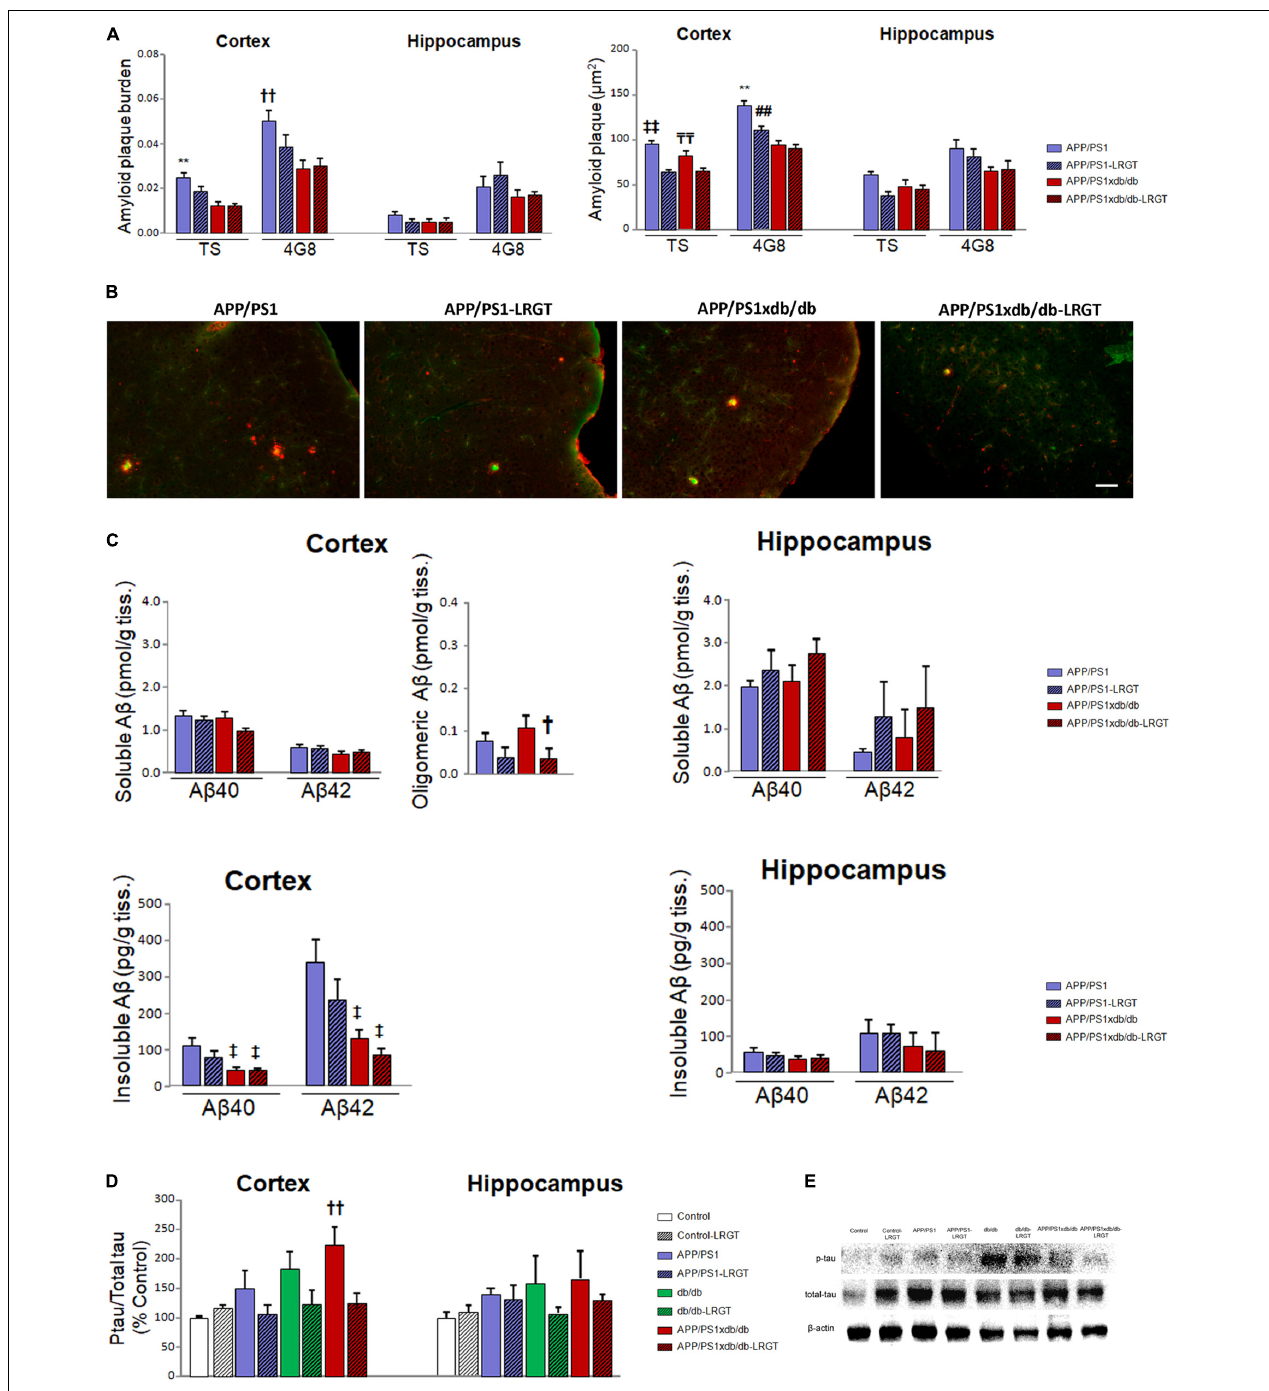
FIGURE 4 | LRGT affects amyloid and tau pathologies in APP/PS1xdb/db mice. (A,B) Amyloid plaque burden and size are quantified by thioflavin S and 4G8 staining. (C) A β 40, A β 42, and A β aggregates are also determined in APP/PS1 and APP/PS1xdb/db mice after liraglutide treatment (500 µ g/kg/day) for 22 weeks. (D,E) Phospho-tau/total tau ratios are also measured in all the genotypes (Control, APP/PS1, db/db, and APP/PS1xdb/db) under study untreated or after LRGT treatment (complete statistical analysis included as a Supplementary Material ). (A) LRGT treatment reduced amyloid plaque burden in the cortex from APP/PS1 mice (** p < 0.01 vs. rest of the groups; †† p < 0.001 vs. APP/PS1xdb/db, and APP/PS1xdb/db-LRGT). No differences were observed in the hippocampus. LRGT treatment also reduced amyloid plaque size in the cortex from APP/PS1xdb/db mice ( p < 0.01 vs. APP/PS1-LRGT and APP/PS1xdb/db-LRGT, p < 0.001 vs. APP/PS1-LRGT; ** p < 0.01 vs. rest of the groups, ## p < 0.001 APP/PS1xdb/db-LRGT). No differences were observed in the hippocampus. Data are representative of five animals. (B) Illustrative image of TS (green) and 4G8 (red) staining of amyloid plaques in the cortex from all the groups studied. Scale bar = 50 µ m. (C) No